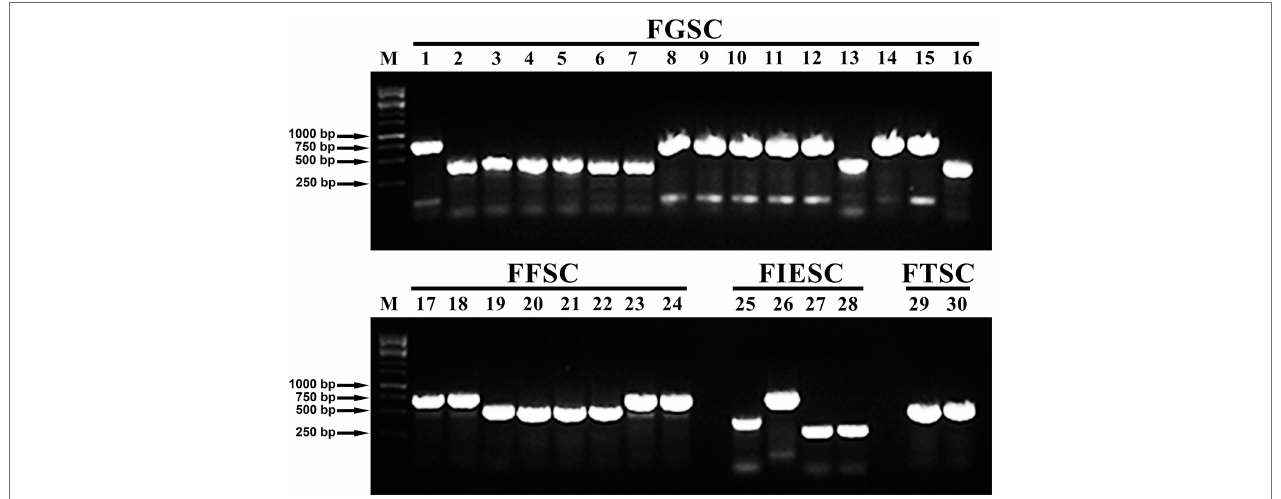
FIGURE 3 | Visualization of PCR-based chemotype analysis from all of the 12 Fusarium species using representative isolates. Lane M: Marker; Lanes 1: detection of 15Ac-deoxynivalenol (DON) chemotypes produced by the F. graminearum isolate (YNF16-37); Lanes 2–7: detection of nivalenol (NIV) chemotypes produced by F. meridionale isolates (YNF15-50, YNF15-21, YNF15-78, YNF15-29, YNF16-19, and YNF16-55); Lanes 8–12: detection of 15Ac-DON chemotypes produced by F. boothii isolates (YNF15-23, YNF15-40, YNF16-17, YNF16-68, and YNF16-113); Lanes 13: detection of NIV chemotypes produced by the Fusarium asiaticum isolate (YNF15-56); Lanes 14: detection of 15Ac-DON chemotypes produced by the F. asiaticum isolate (YNF15-59); Lanes 15: detection of 15Ac-DON chemotypes produced by the Fusarium cortaderiae isolate (YNF16-101); Lanes 16: detection of NIV chemotypes produced by the F. cerealis isolate (YNF16-22); Lanes 17–18: detection of fumonisin (FUM) chemotypes produced by F. proliferatum isolates (YNF15-10 and YNF16-118); Lanes 19–22: detection of beauvericin (BEA) chemotypes produced by F. temperatum isolates (YNF15-67, YNF16-04, YNF16-77, and YNF16-116); Lanes 23–24: detection of FUM chemotypes produced by F. verticillioides isolates (YNF15-04 and YNF15-98); Lanes 25: detection of 3Ac-DON chemotypes produced by the F. incarnatum isolate (YNF15-87); Lanes 26: detection of 15Ac-DON chemotypes produced by the F. incarnatum isolate (YNF15-93); Lanes 27–28: detection of zearalenone (ZEN) chemotypes produced by F. equiseti isolates (YNF15-01 and YNF15-64); Lanes 29–30: detection of BEA chemotypes produced by F. avenaceum isolates (YNF16-15 and